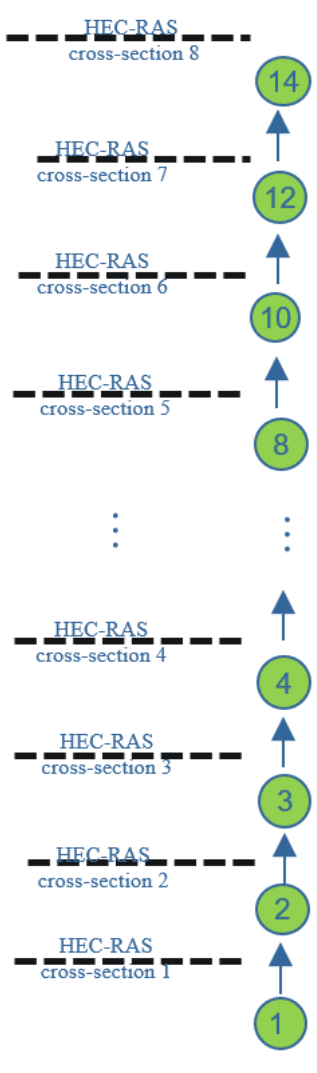
Figure 2. Model segmentation.